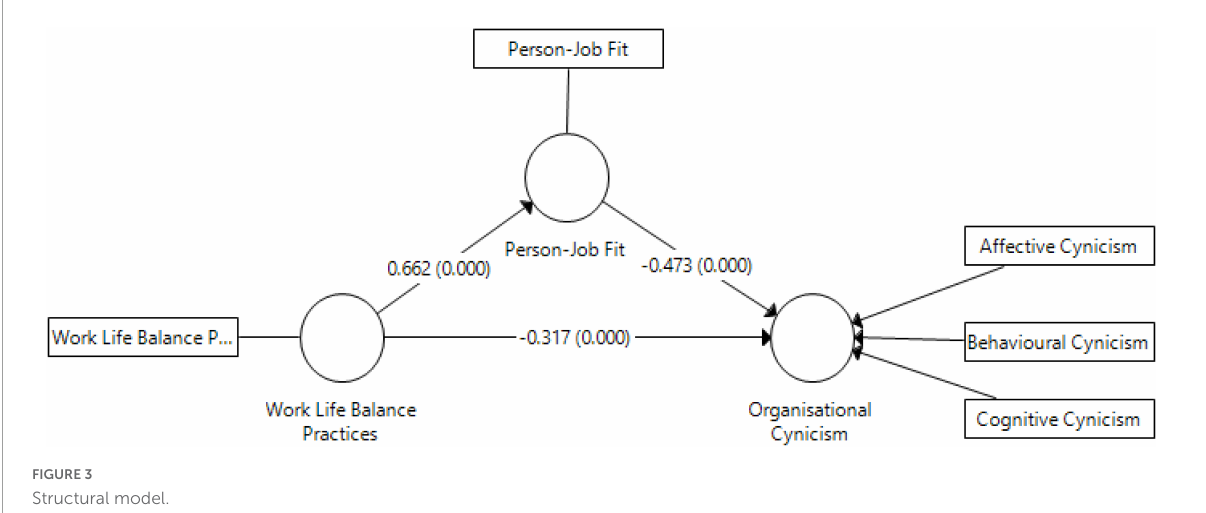
FIGURE3 Structural